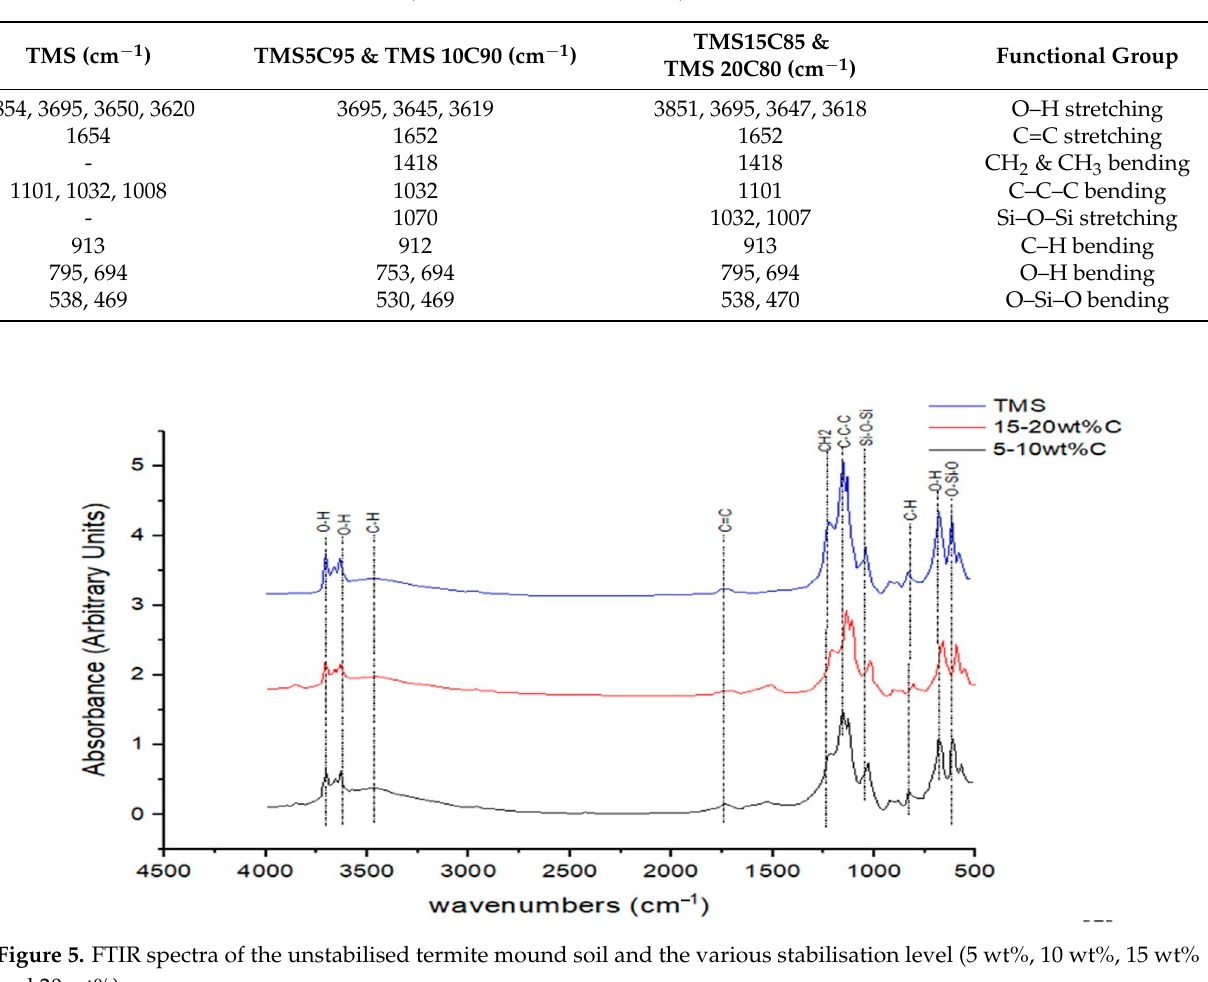
Table 2. Peaks and functional groups present in the various samples. Termite mound soil (TMS), termite mound soil